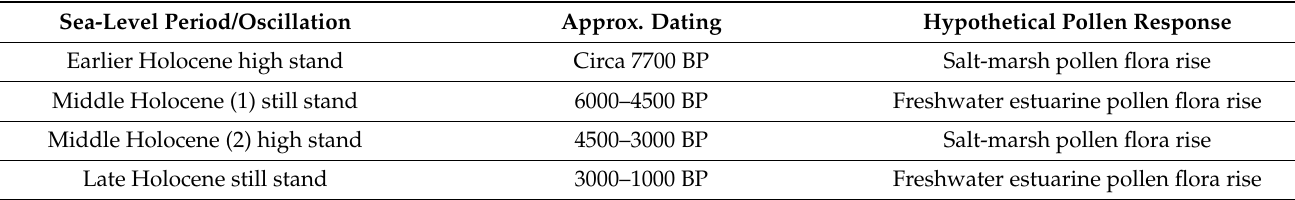
Table 2. Summary sea-level history model and testing by